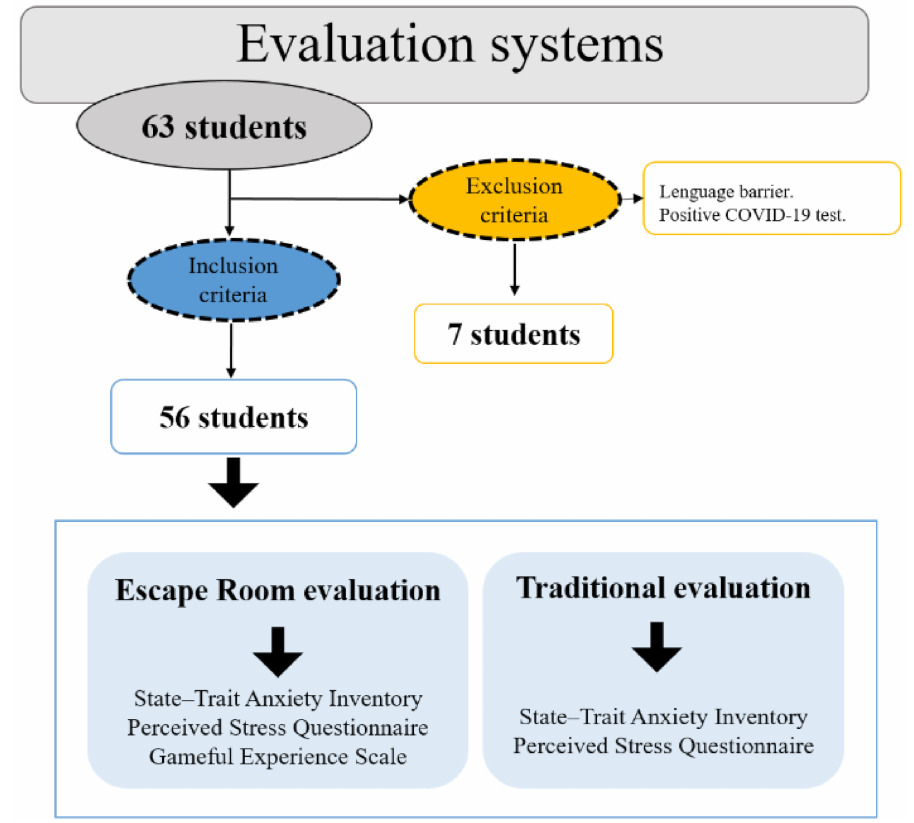
Figure 1. Flow diagram of